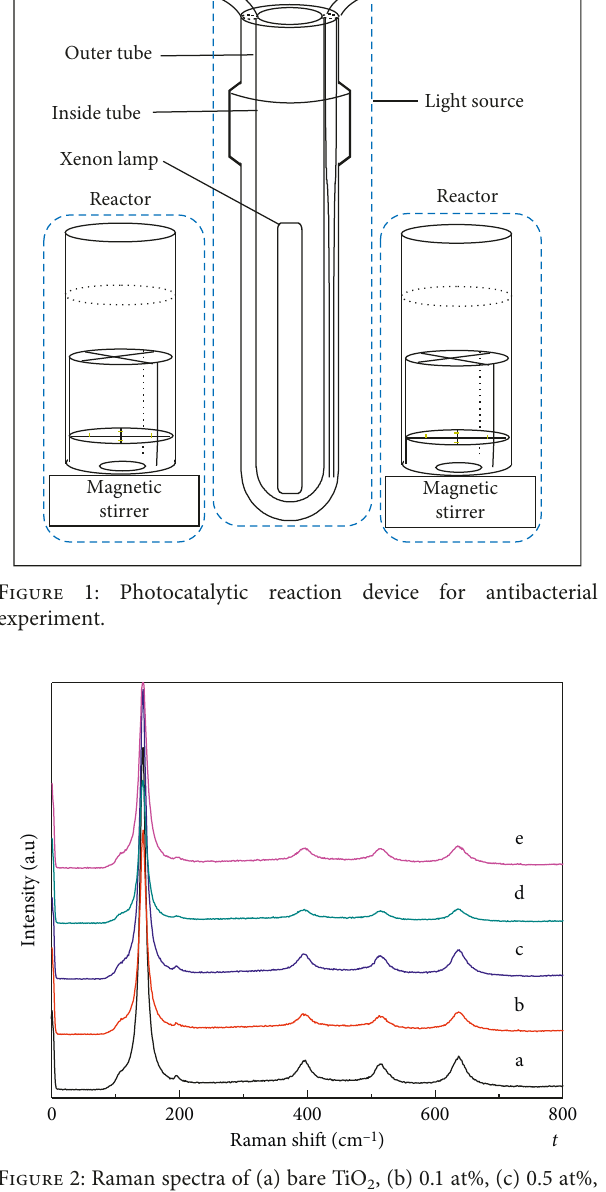
2 , (b) 0.1 at%, (c) 0.5 at%, 2 films with different